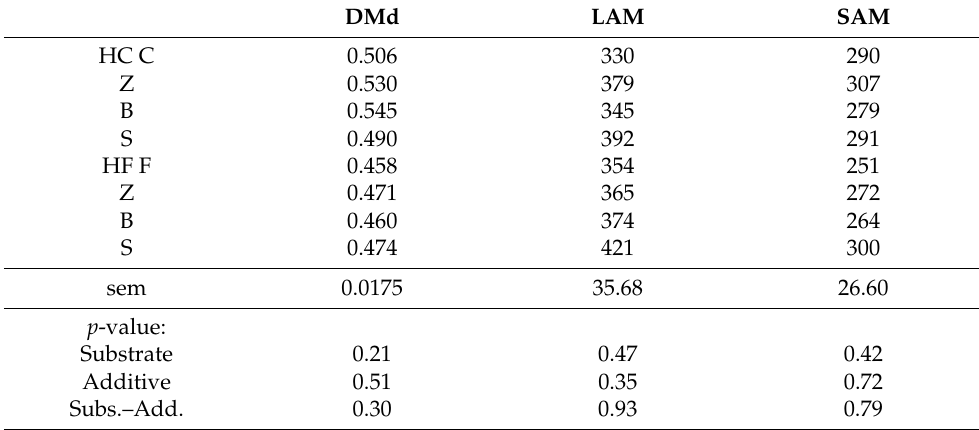
Table 3. Dry matter disappearance (DMd) at 24 h incubation, liquid-associated microbial mass (LAM, µ g/mL), and solid residue (SAM, µ g/g) from a 65:35 (HC) or a 35:65 (HF) concentrate-to-forage substrate, alone (C, F) or supplemented with 10 mg/g of clay minerals (zeolite, Z; bentonite, B; or sepiolite, S). sem: standard error of